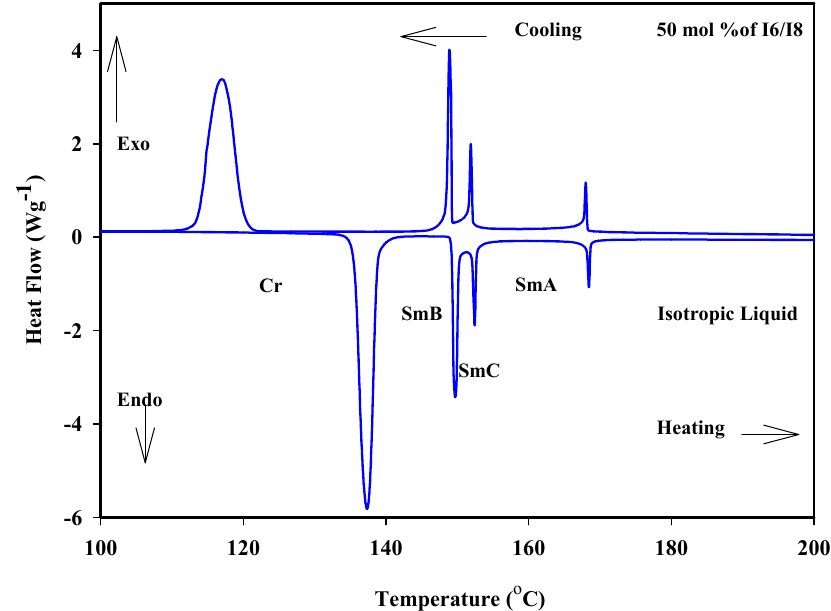
Figure 2. DSC thermogram for 50 mol% I6/I8 binary system during heating and cooling states at rate 10 °Cmin − 1 .